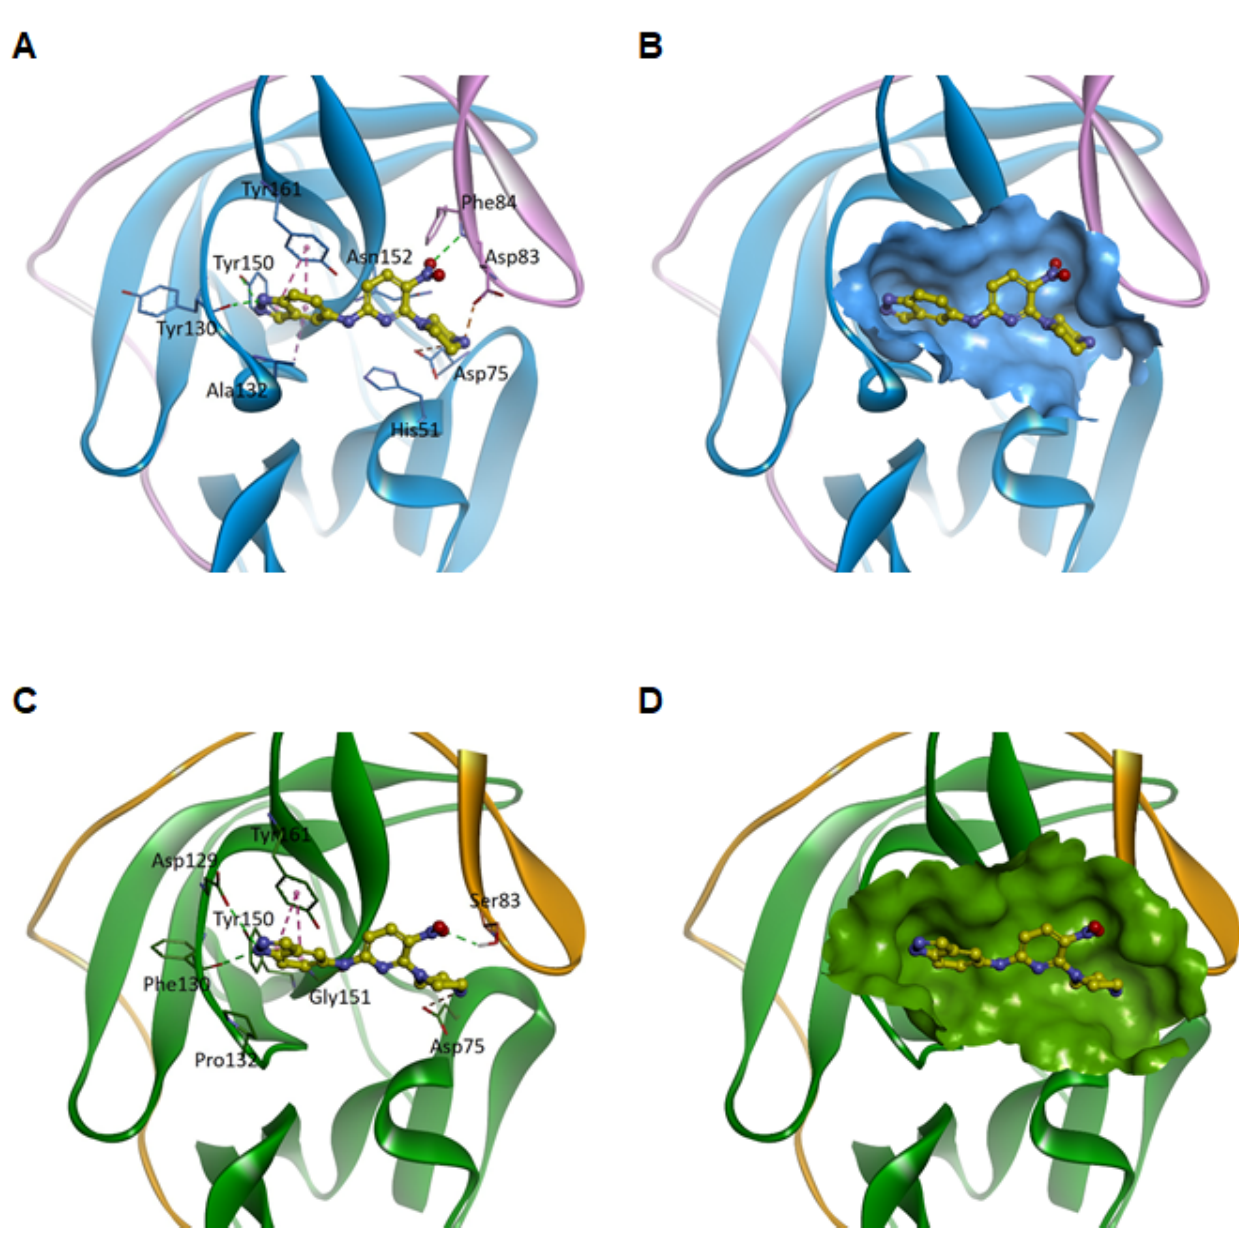
Figure 5. Predicted binding modes of compound 1 for viral NS2B-NS3 proteases. ( A ) Binding of compound 1 (yellow ball and stick model) to the ZIKV NS2B-NS3 protease (pink-blue ribbon model) and ( B ) surface model of the binding site of ZIKV NS2B-NS3. ( C ) Binding of compound 1 (yellow ball and stick model) to the DENV-4 NS2B-NS3 protease (orange-green ribbon model) and ( D ) surface model of the binding site of DENV-4 NS2B-NS3. For clarity, key binding site residues are shown in sticks and labeled using the 3-letter amino acid code. The hydrogen bonds are displayed as green dashed lines and hydrophobic interactions are shown as pink dashed lines. In addition, electrostatic interactions are indicated by orange dashed lines.